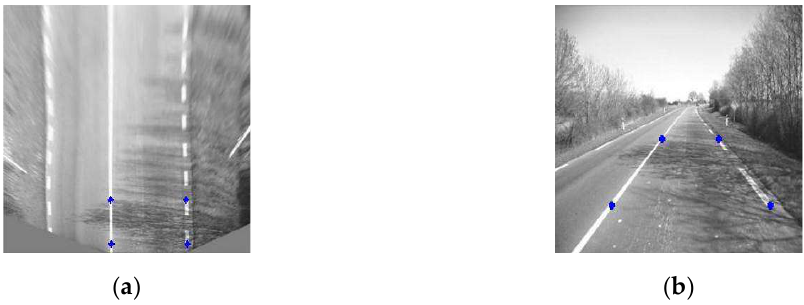
Figure 4. Image comparison before and after affine transformation: ( a ) Original gray image; ( b ) Affine transformation image.